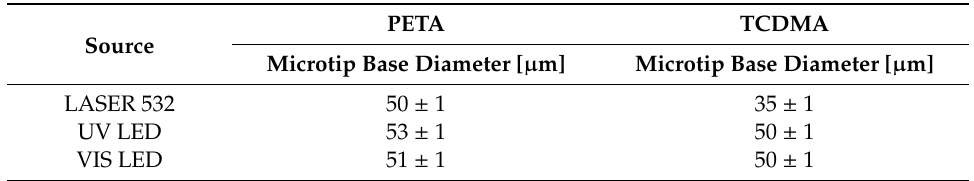
Table 1. The main parameters of microtips with optimal reflective properties, manufactured on MMF62.5 by means of different light sources (used optical power 30 µ W and exposition time equal to 30